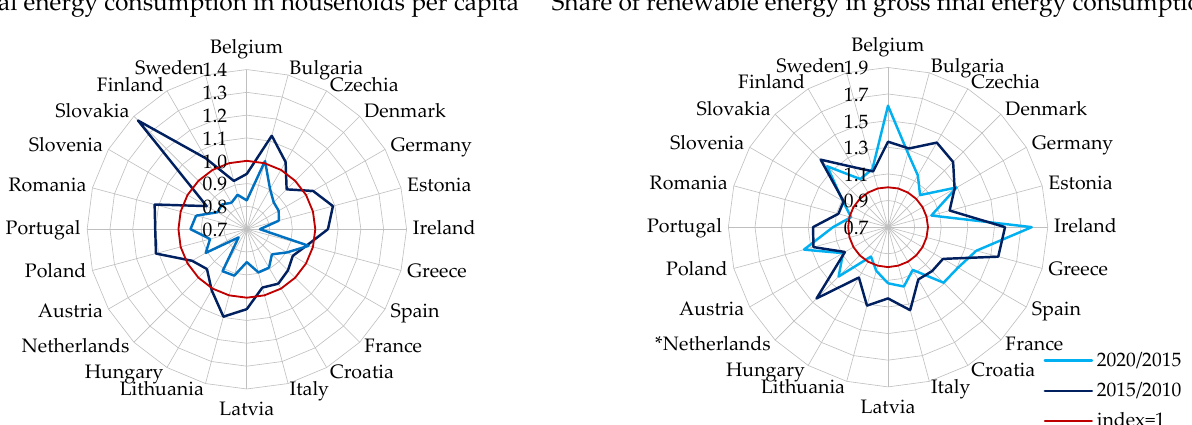
Figure 4. Indices of energy sustainability indicators. *: index value 2020/2015